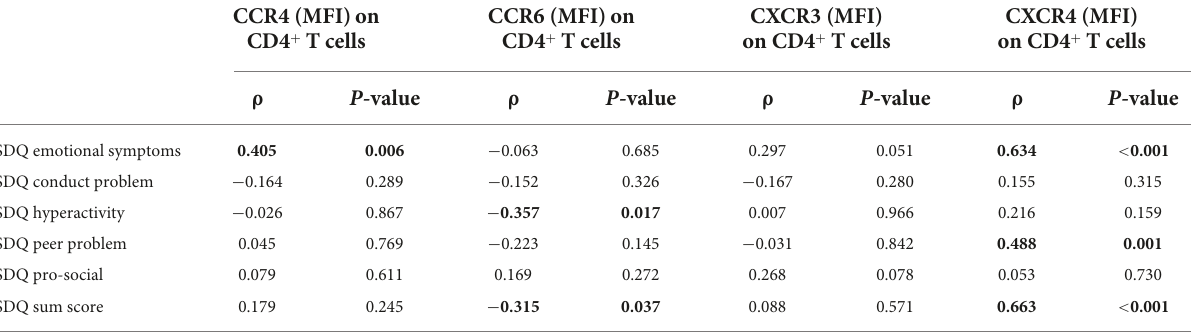
TABLE 4 Correlation of immune parameters with psychological characteristics in AN and